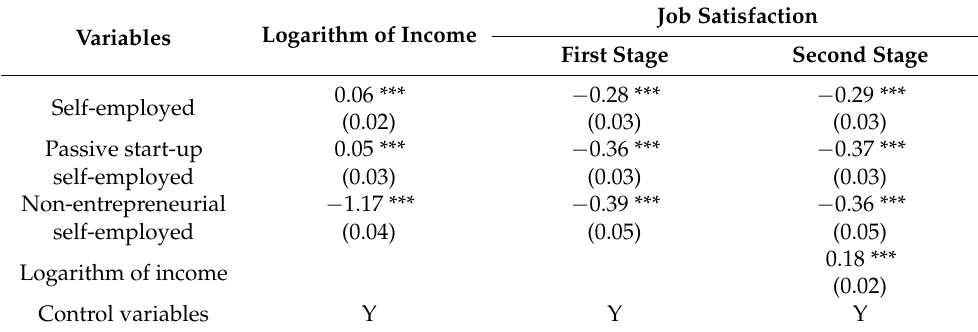
Table 9. OLS regression results of the effect of logarithm of income on job satisfaction. Variables